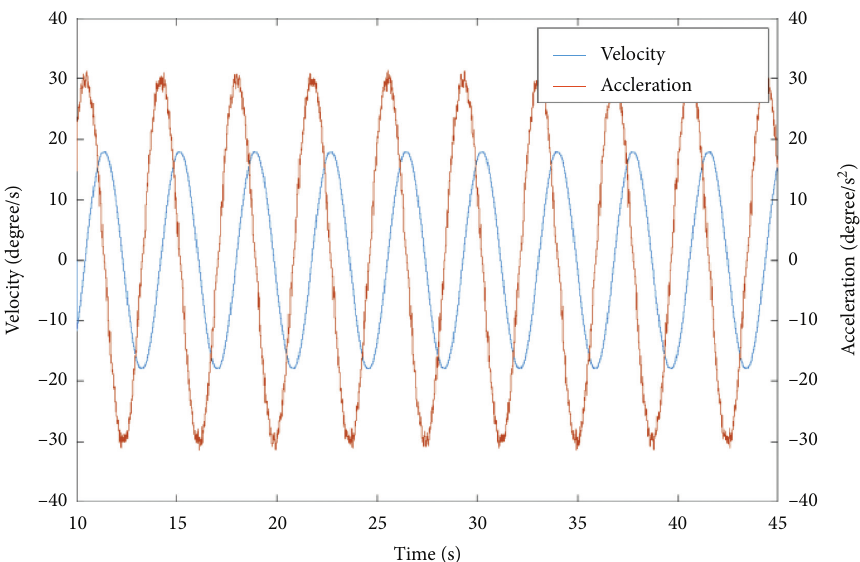
Figure 11: Velocity and acceleration